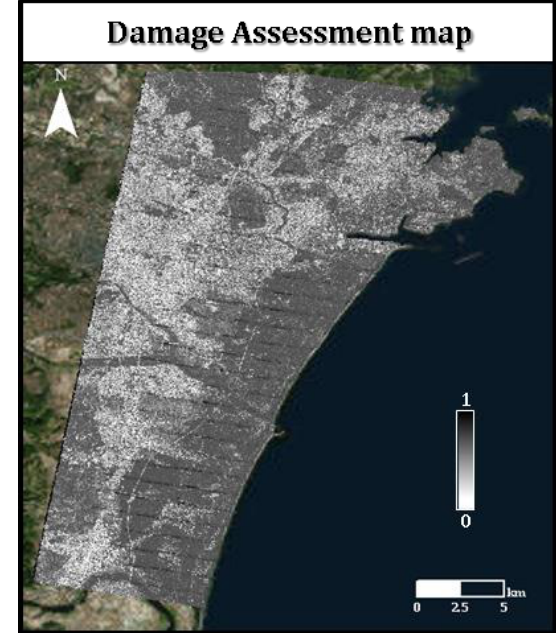
Figure 4. Damage assessment map produced by integration of coherence and CE methods. White color (value 0) represents no change=stability. Stability is mostly apparent in urban areas and made-man structures, like roads. Black color (value 1) represents severe damage, seen mostly along the coastline.